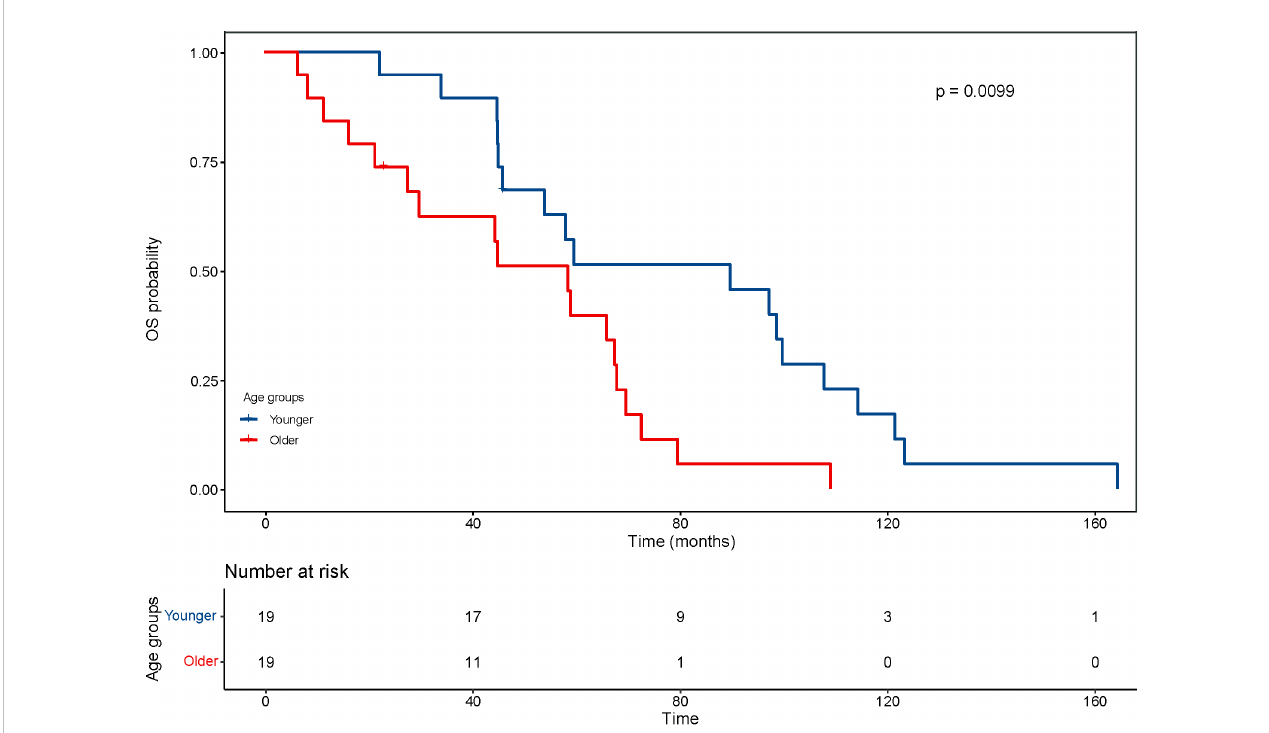
FIGURE 4 Kaplan – Meier curves for overall survival (OS) of patients with small hepatocellular carcinomas after cryoablation. The log-rank test showed signi fi cant difference between the elderly and young groups (P